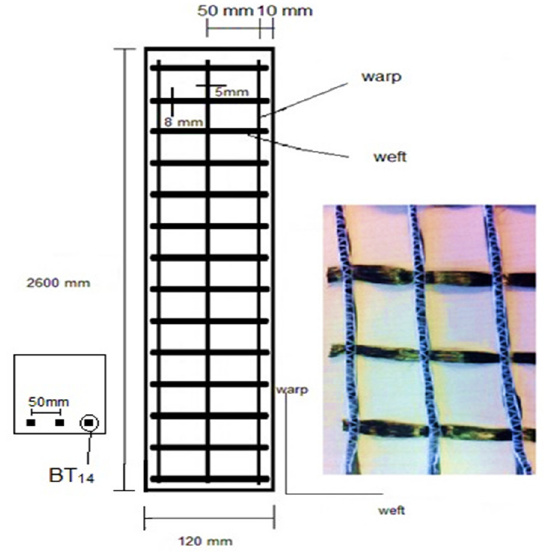
Figure 4. The arrangement of textile fibres in bi-axial TRC beams.